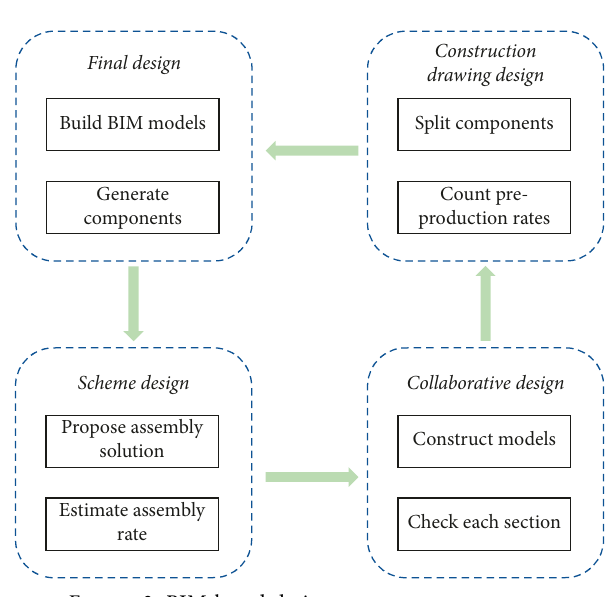
Figure 3: BIM-based design management